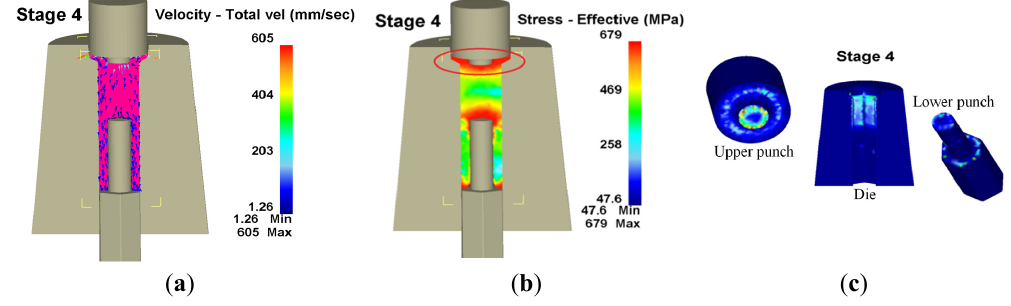
Figure 11. Velocity, effective stress and wear distribution of the third stage in 3D. ( a ) Velocity; ( b ) Effective stress; ( c ) Wear.